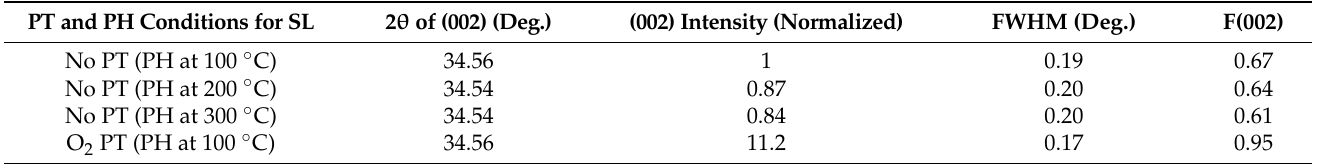
Table 2. Parameters of ZnO NR crystals extracted from XRD analysis.